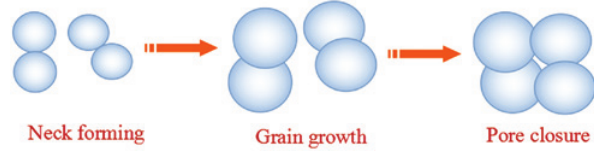
Figure 5: Schematic diagram of the formation of pore in the pantograph.